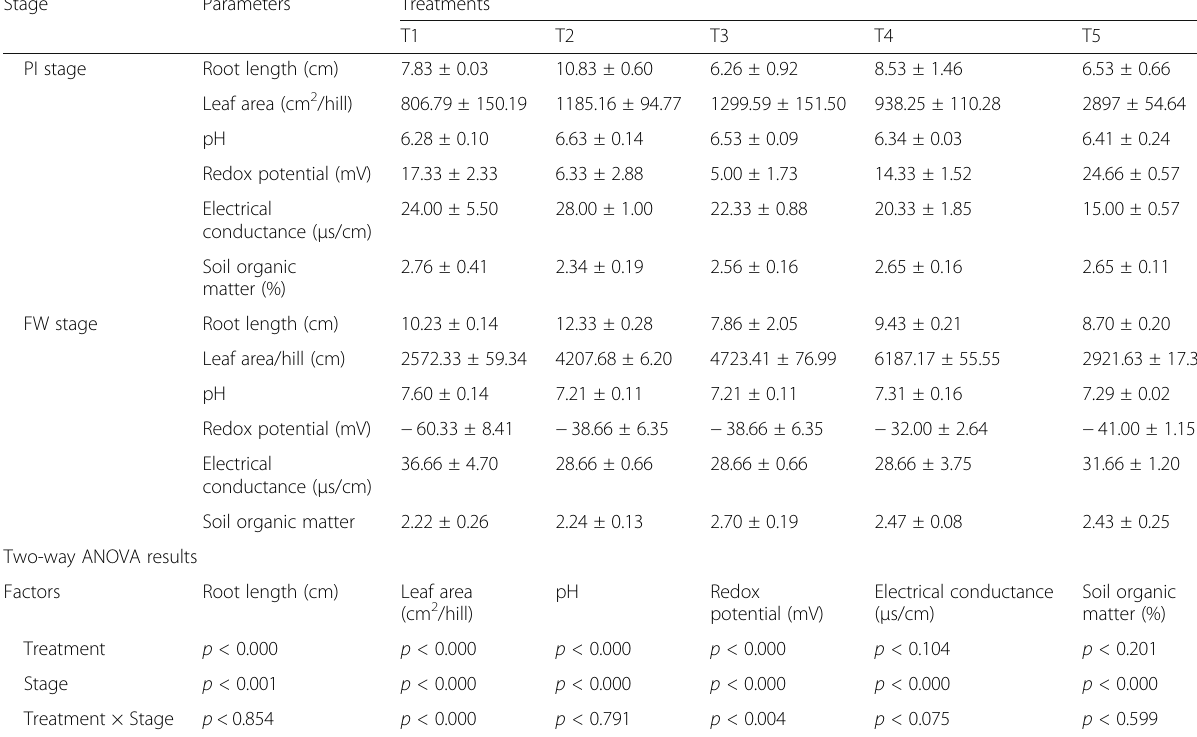
Table 3 Temporal variation of parameters (mean ± standard error) of plant and soil during PI (panicle initiation) and FW (flowering) stages of the crop growth period